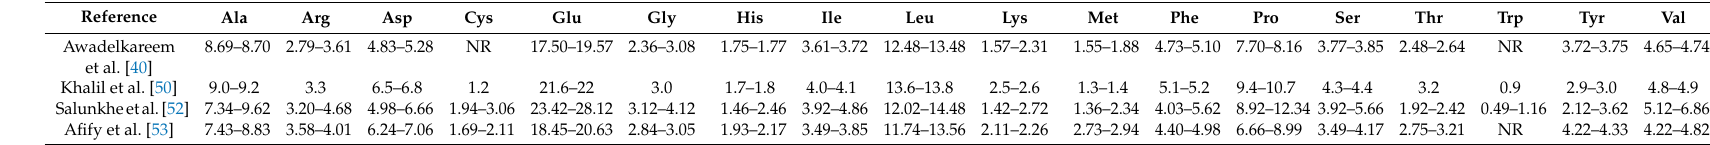
Table 2. Amino acid composition (g / 100 g) of sorghum.